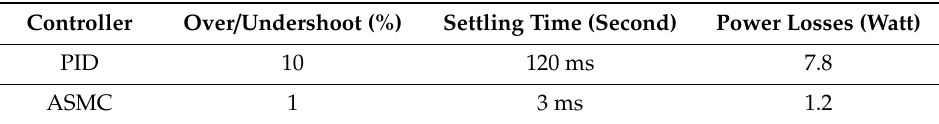
Table 5. Performance characteristics of the conventional controller and the proposed ASMC controller based on PSO 40